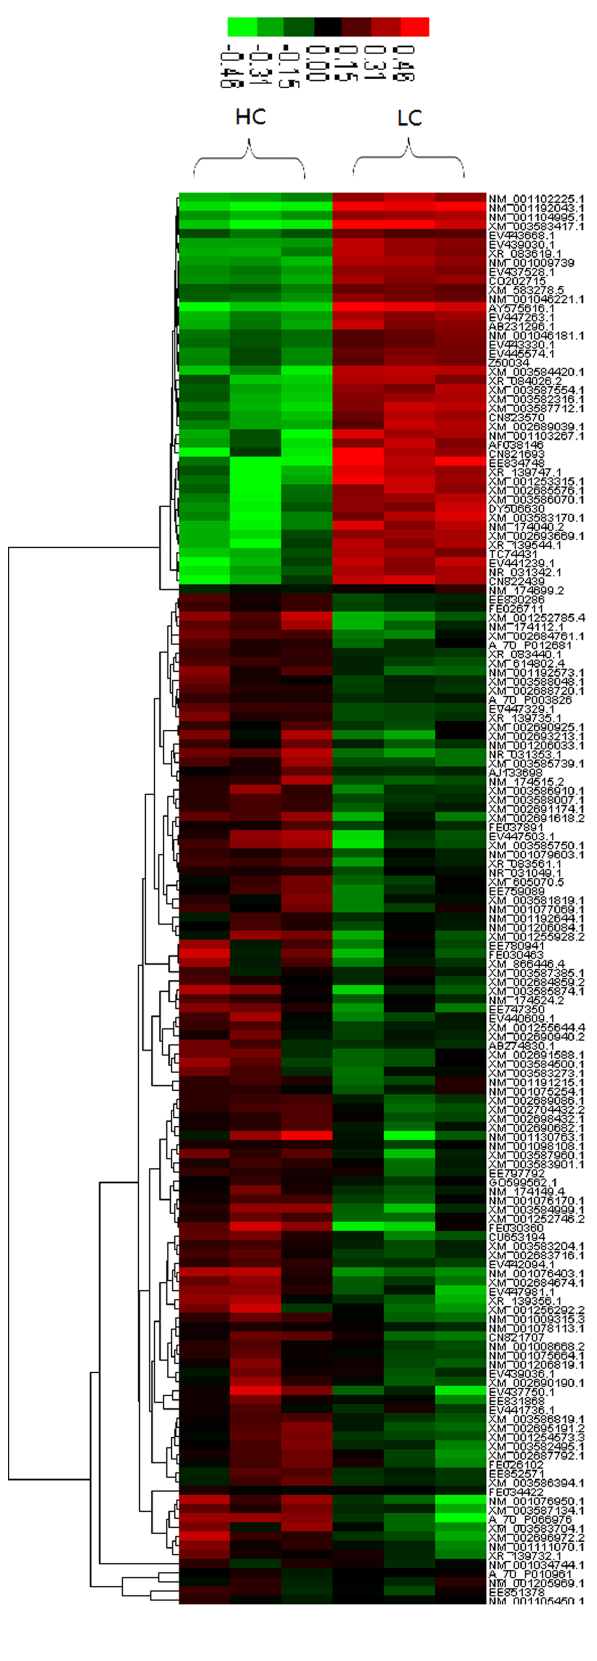
Figure 3. Hierarchical cluster analysis of the differentially expressed transcripts (n=155). 155 transcripts were differentially expressed (adjusted p , 0.01 ). Red and green colors reflect the high and low intensities,